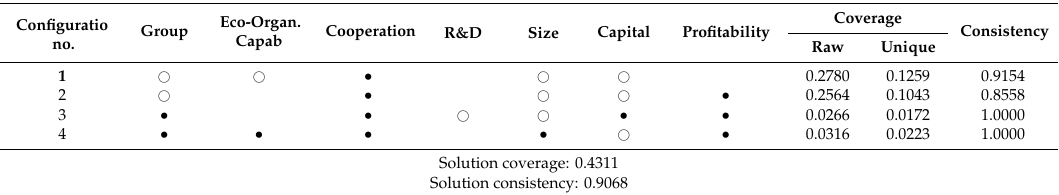
Table 6. Model predicting the development of internal technological eco-innovations (product or process) in agri-food